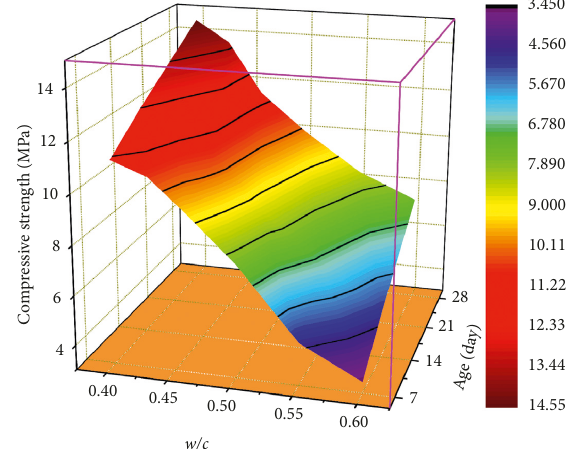
Figure 8: Average compressive strength of the gangue concrete at different ages with different water-cement ratios (gangue content: